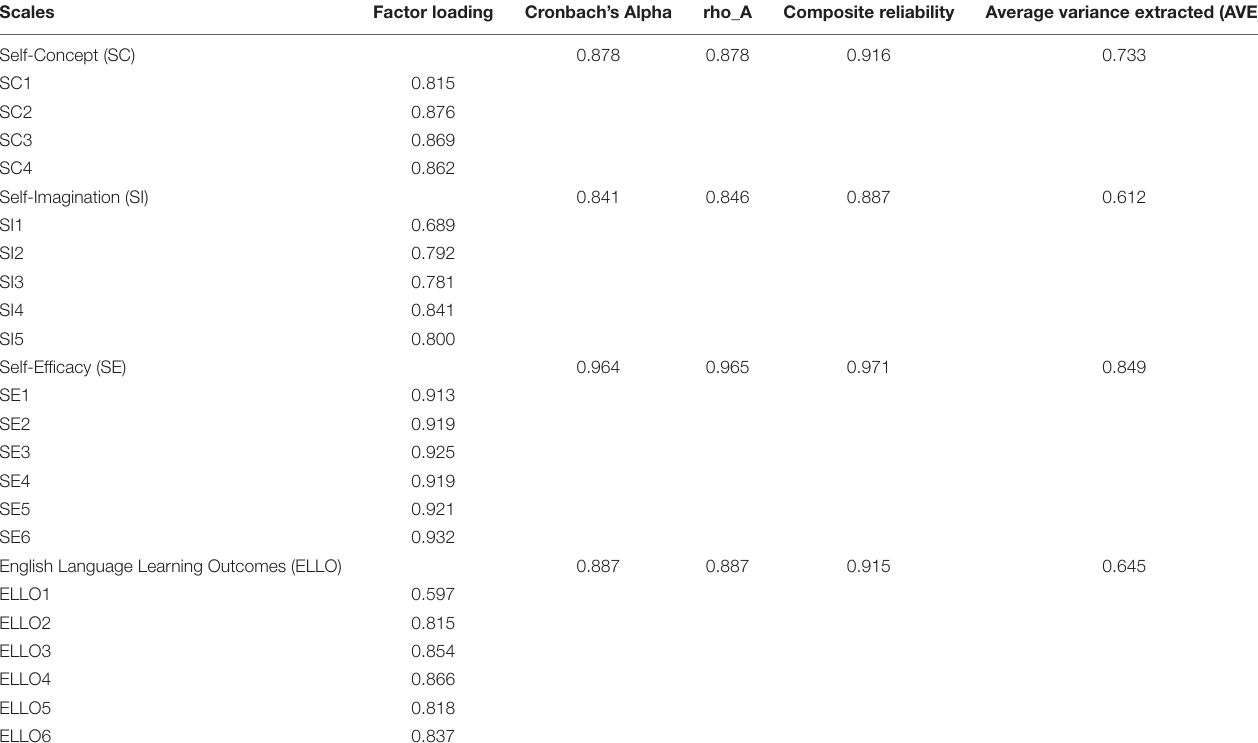
TABLE 1 | Reliability and validity.